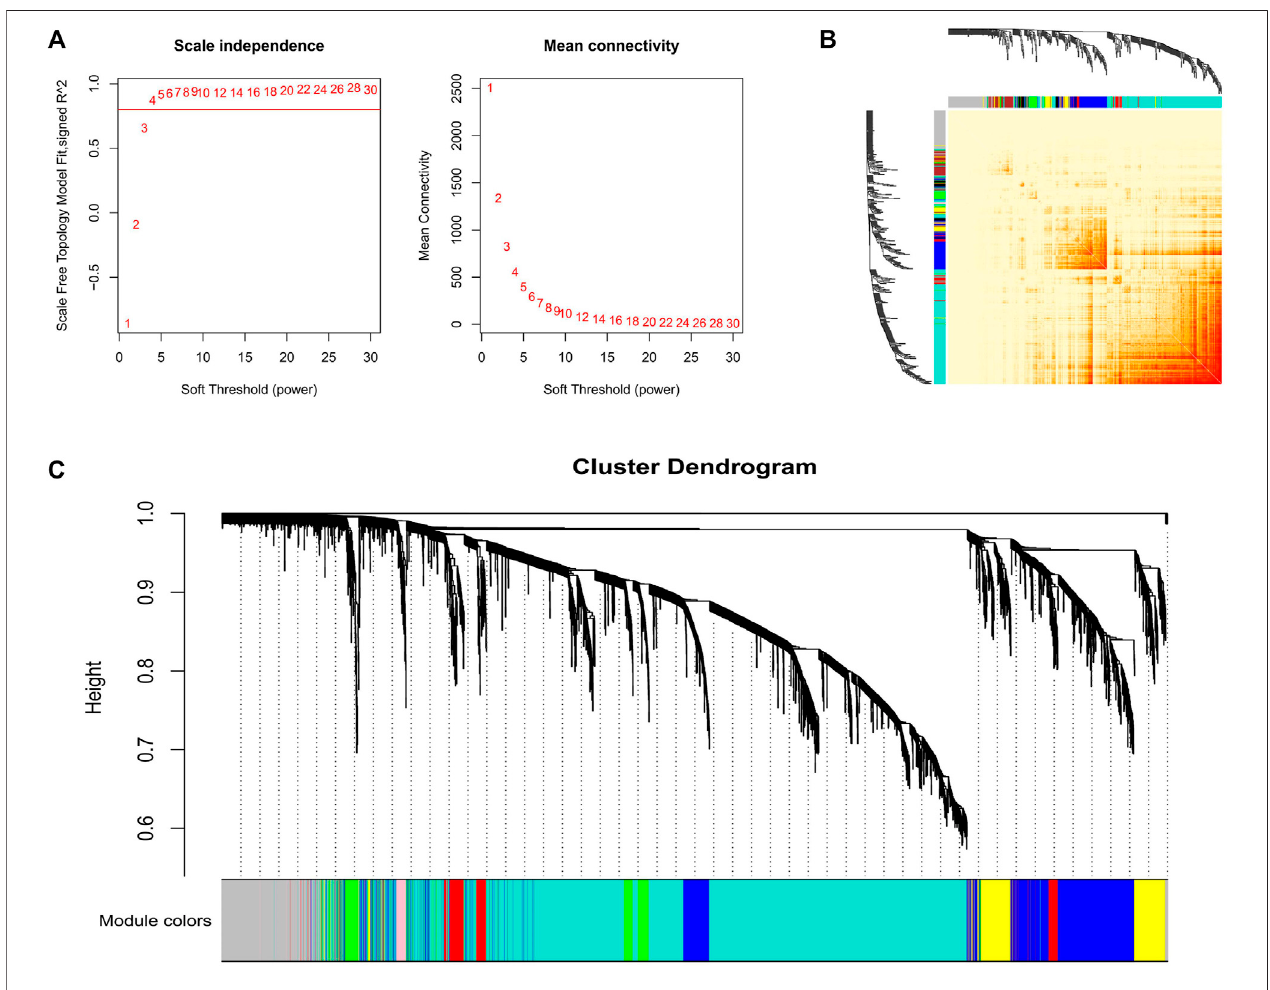
FIGURE2| Geneco-expressionnetworksinGSE39618. (A) Analysisofthescale-free fi tindexfor varioussoft-thresholding powers (Left) andanalysisofthemean connectivity for various soft-thresholding powers (Right); (B) Network heatmap plot in the co-expression modules. (C) Clustering dendrogram of the genes.